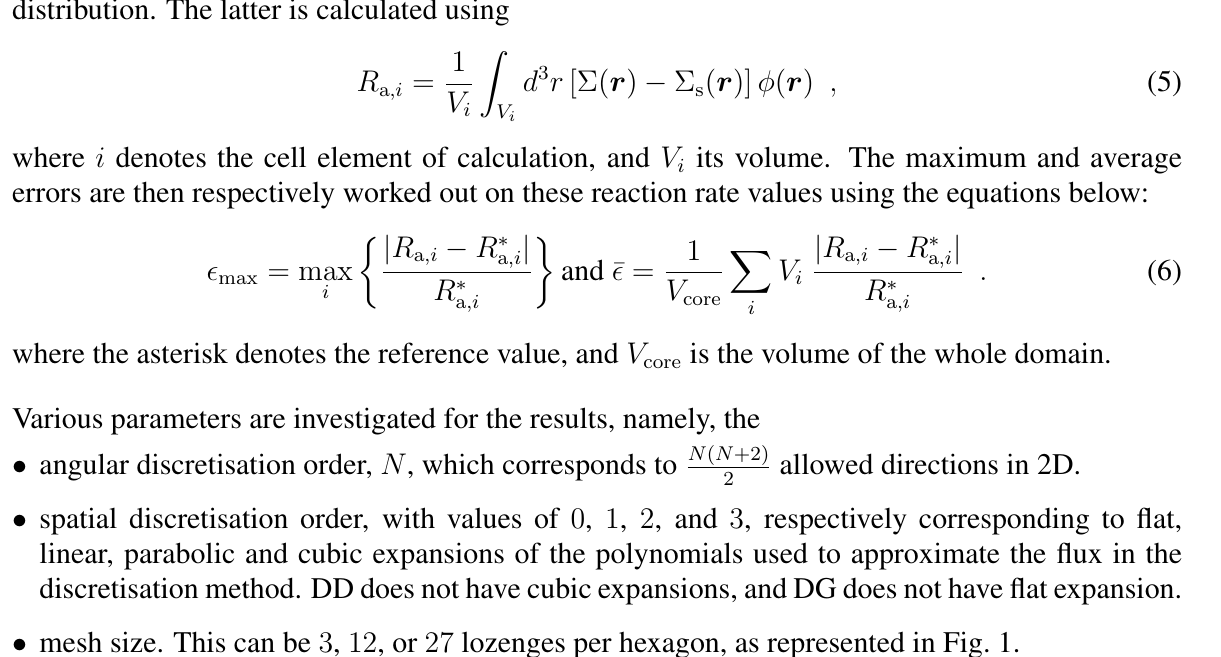
Figure 3: Domain of the 2D one-group benchmark, featuring a 30 ◦ symmetry, the material mixtures, and vacuum boundary conditions. Hexagon side is 19 cm.